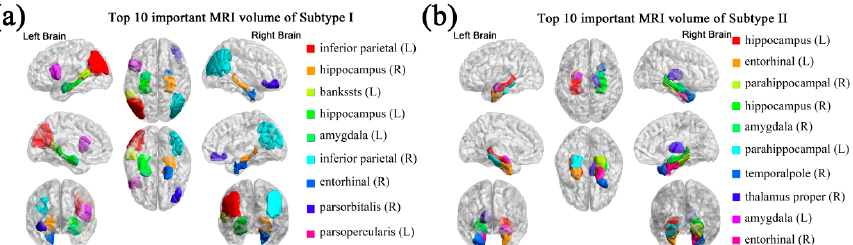
Figure 4. Important sMRI features with an impact on the progression of MCI patients vary across subtypes. Anatomical locations of brain regions with top 10 important sMRI volume features using BrainNet in ( a ) subtype I and ( b ) subtype II. Corpus callosum mid-anterior (CC_Mid_Anterior) in subtype I is not shown.